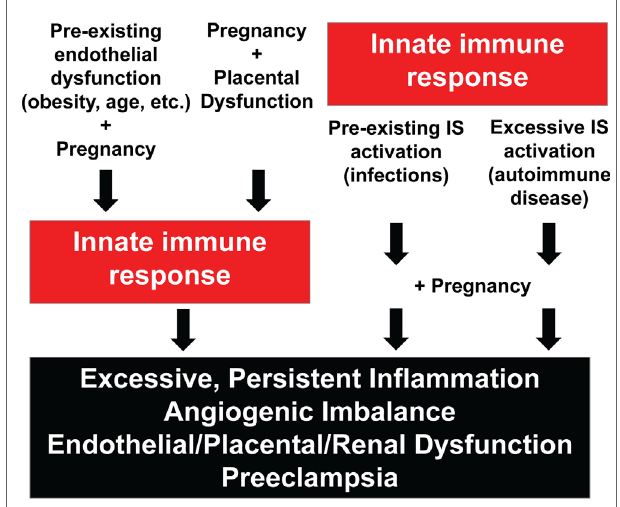
FiGUre 1 | Four pathways involving innate immunity in the pathogenesis of preeclampsia . IS, immune